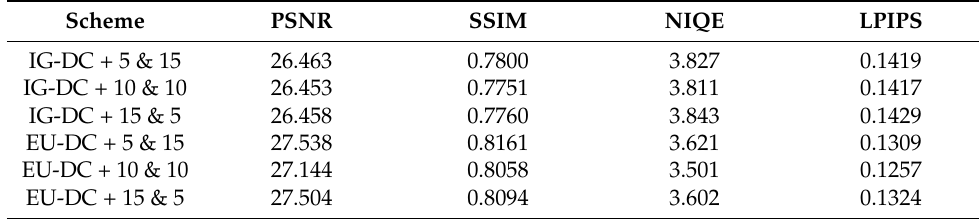
Table 1. A study of the RRDB allocation schemes in the Set14 dataset.